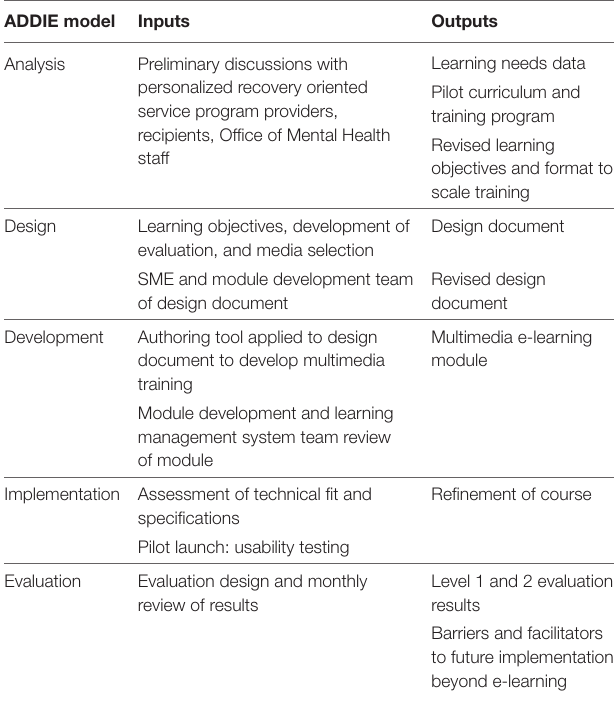
taBle 2 | Using Analyze, Design, Develop, Implement, and Evaluate (ADDIE) to develop individual placement and support